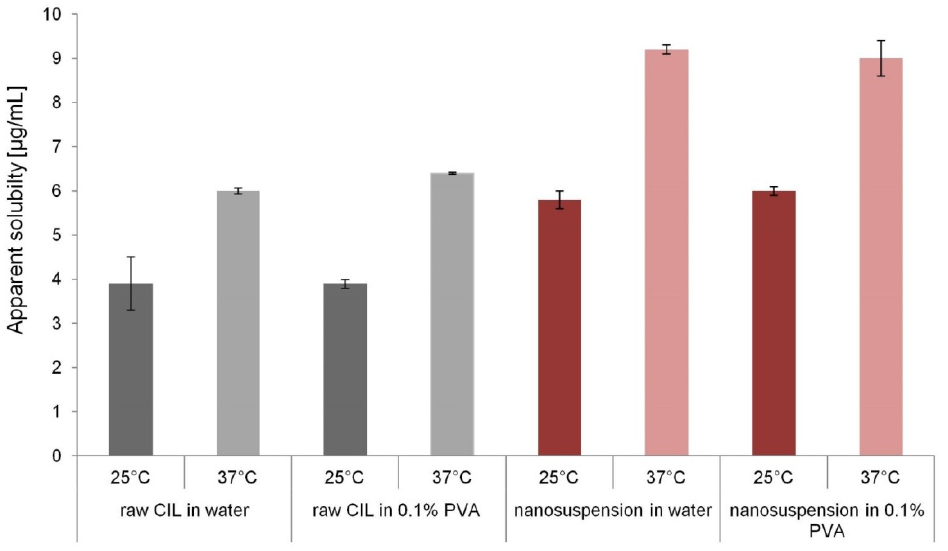
Figure 16. Apparent solubility (mean ± SD, n = 3) of unprocessed cilostazol and nanosuspension in water and in 0.1% PVA solution at 25 °C and 37 °C.